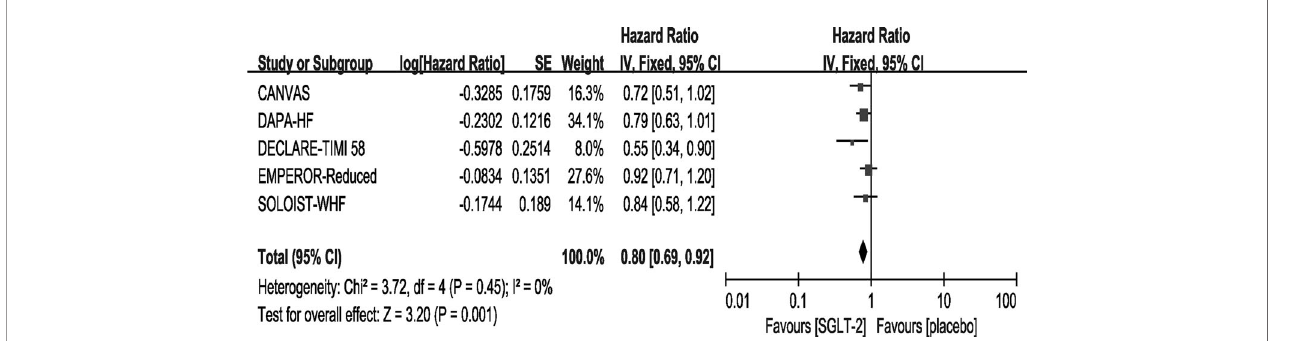
FIGURE 3 | Outcome of CV death in patients with T2DM